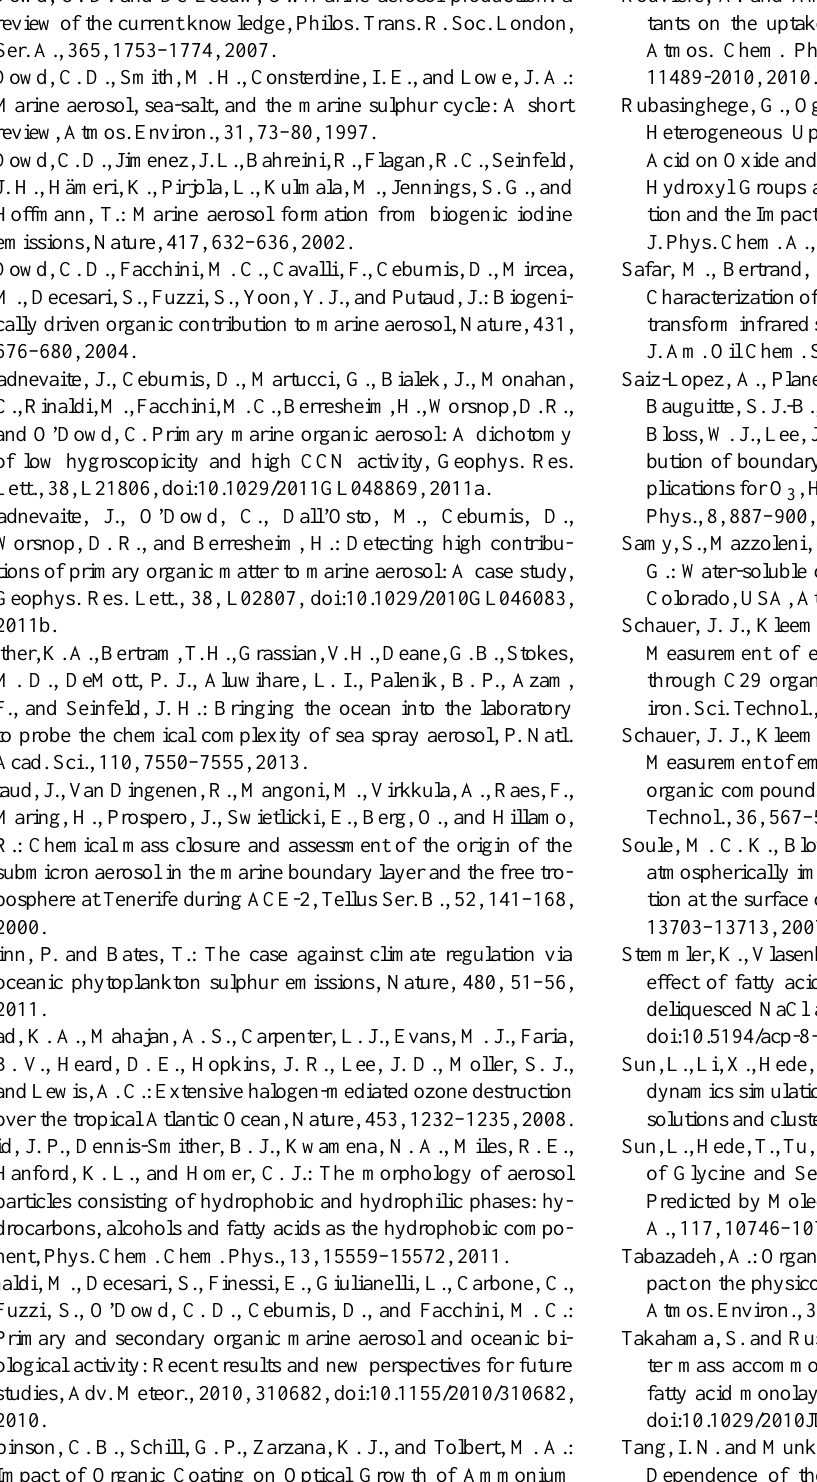
Tabazadeh, A.: Organic aggregate formation in aerosols and its im- pact on the physicochemical properties of atmospheric